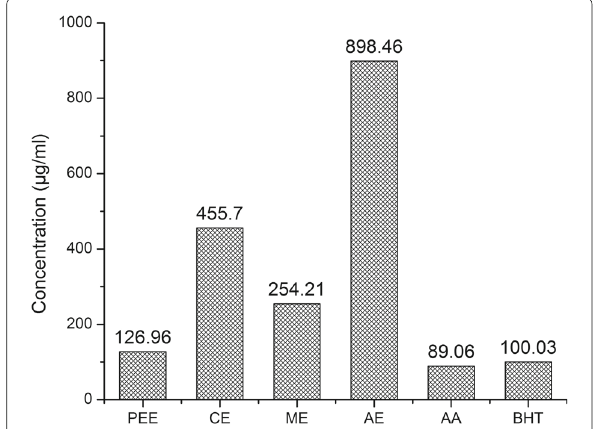
Fig. 2 IC 50 of different extracts of C.pallida stem and standard antioxidants. All tests were done three times. PEE-Petroleum ether extract, CE-Chloroform extract, ME-Methanol extract, AE-Aqueous extract, AA-Ascorbic acid, BHT-Butylated